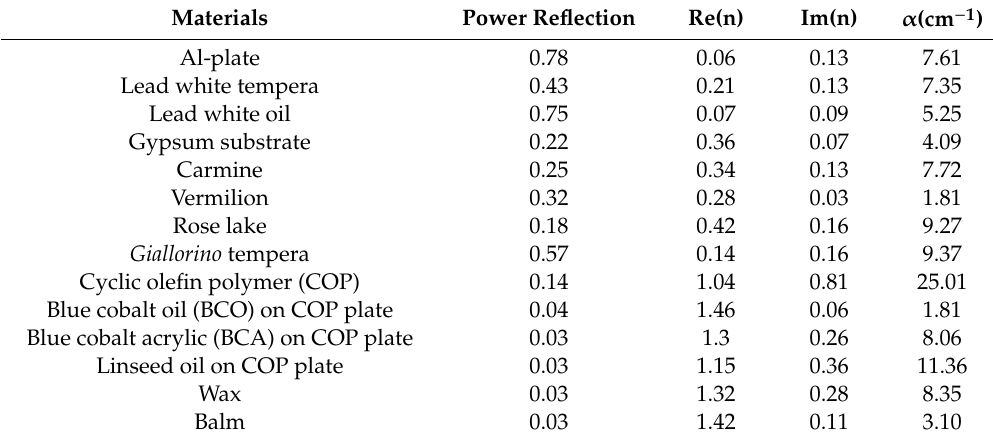
Figure 9. THz imaging scanner measurements on one of the Editech test panels. Table 1. Data on optical properties of some selected artists’